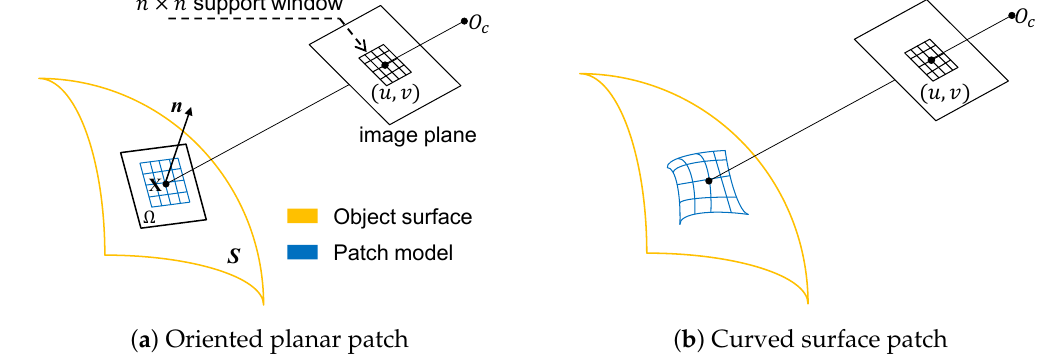
Figure 5. Patch parametrization methods. ( a ) shows the classical planar patch model that assigns a slant plane to the corresponding pixel location, and in ( b ) a smooth curved surface without geometric assumptions is utilized to model the 3D geometry visible in the pixel